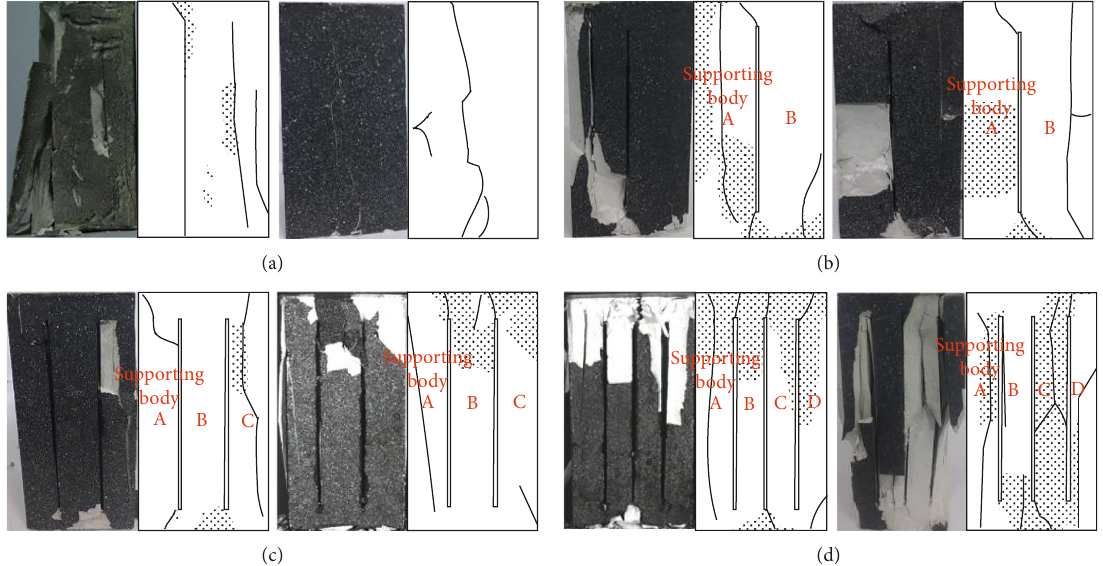
Figure 6: Failure modes of specimens: (a) intact specimen, (b) one fissure specimen, (c) two fissure specimens, and (d) three fissure specimens.